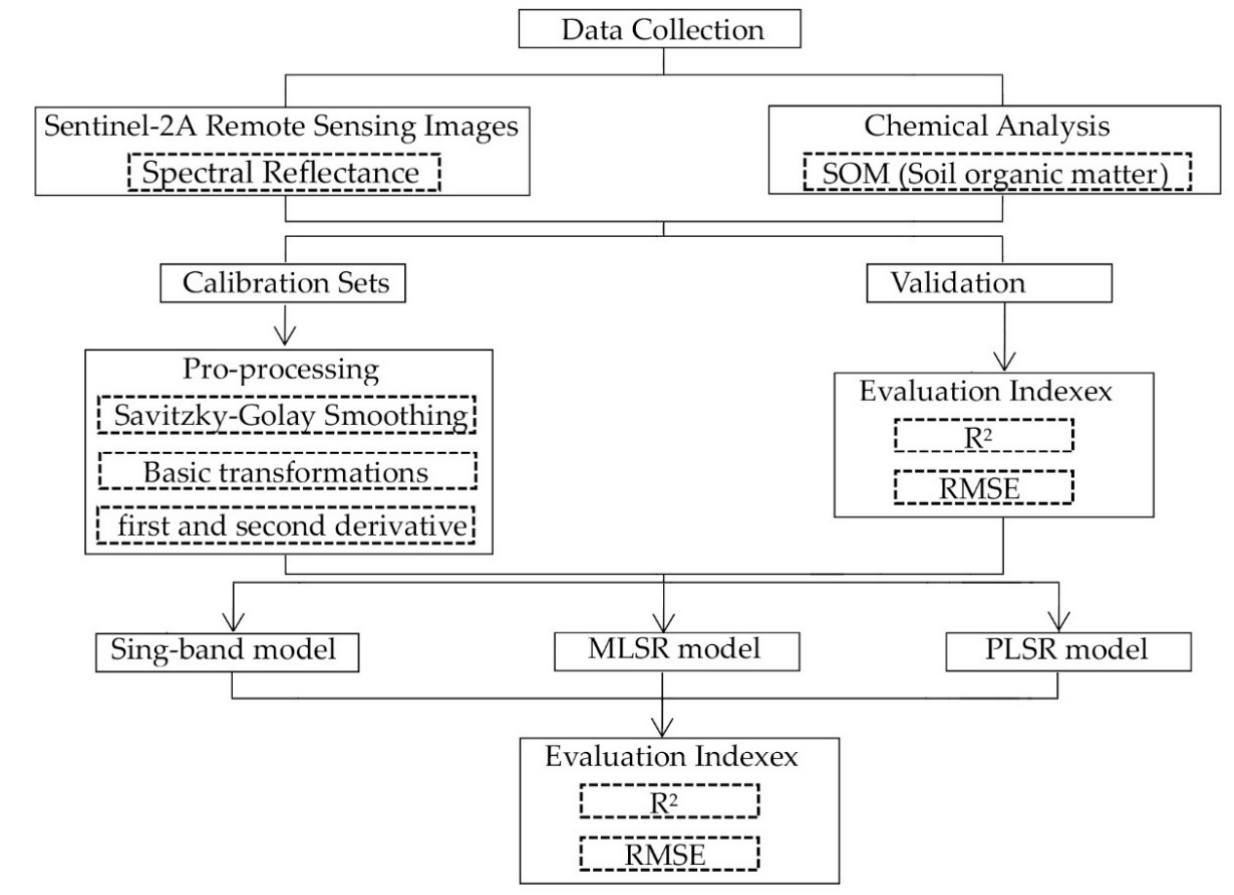
Figure 2. Conducting SOM prediction models.